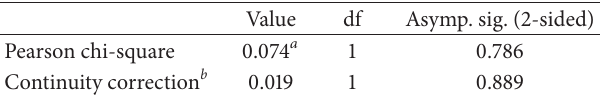
Table 10: House sprayed IRS: malaria occurrence after spraying and using net.